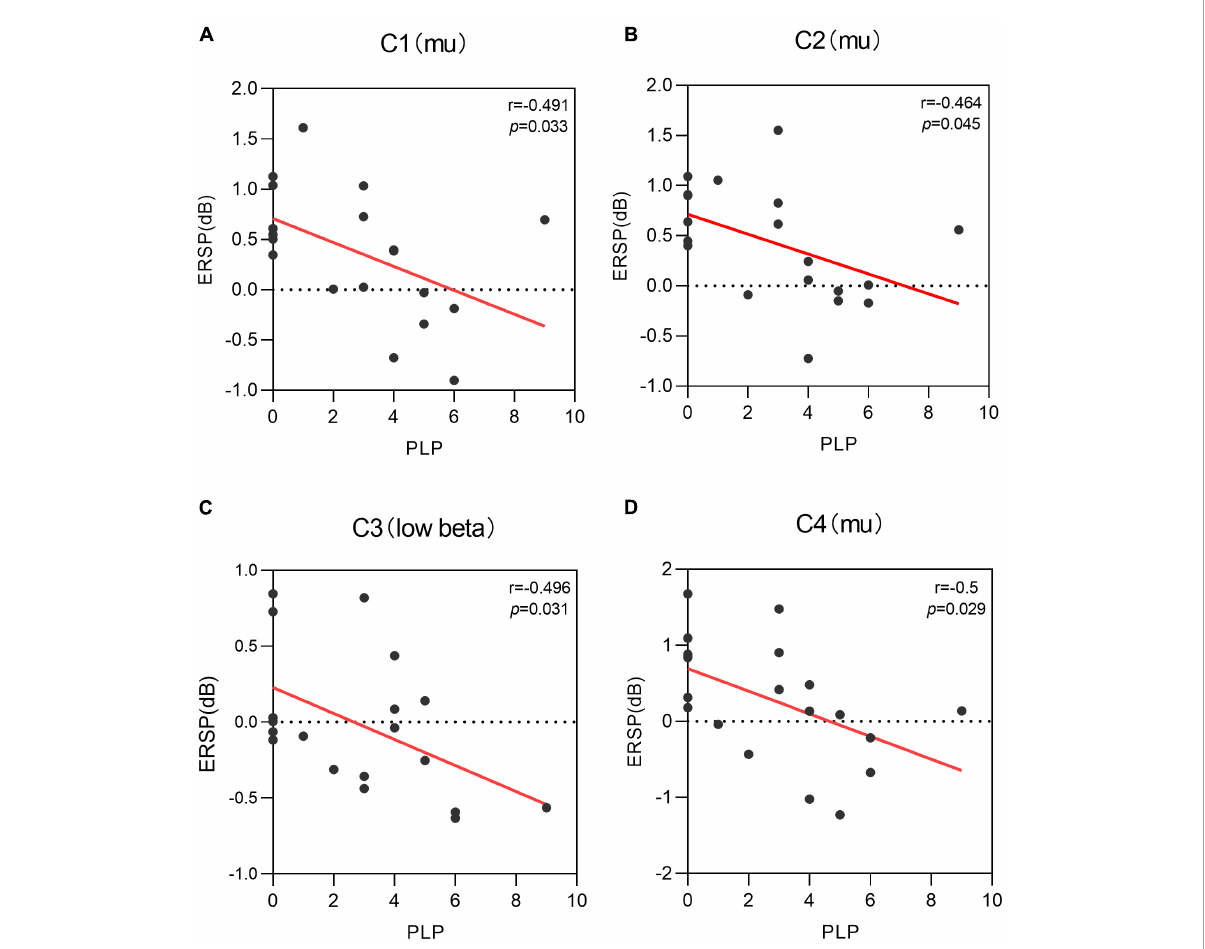
FIGURE6 Correlation of phantom limb pain (PLP) with the power of different electrodes when performing the left motor imagery task, i.e., there is a negative correlation between PLP and the power of multiple electrodes. (A) A negative correlation was found between C1 power values in mu rhythm and PLP level (r = –0.491, p = 0.033). (B) A negative correlation was found between C2 power values in mu rhythm and PLP level (r = –0.464, p = 0.045). (C) A negative correlation was found between C3 power values in low beta rhythm and PLP level (r = –0.496, p = 0.031). (D) A negative correlation was found between C4 power values in mu rhythm and PLP level (r = –0.5, p =